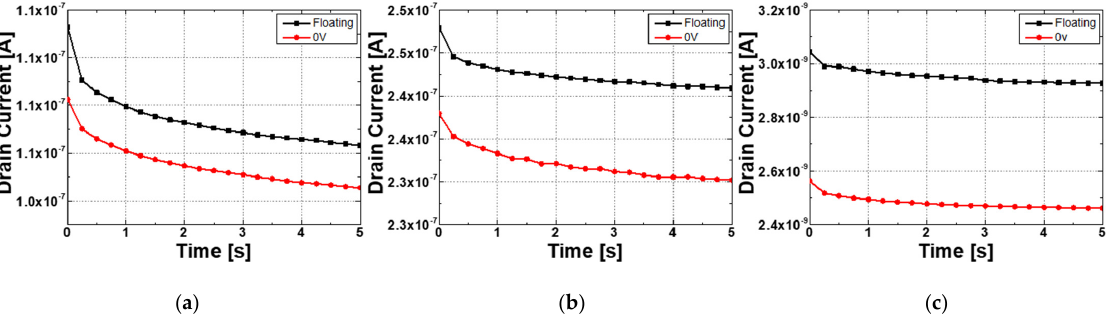
Figure 7. Power consumption test result of the fabricated ZnO TFT device. The black line is the